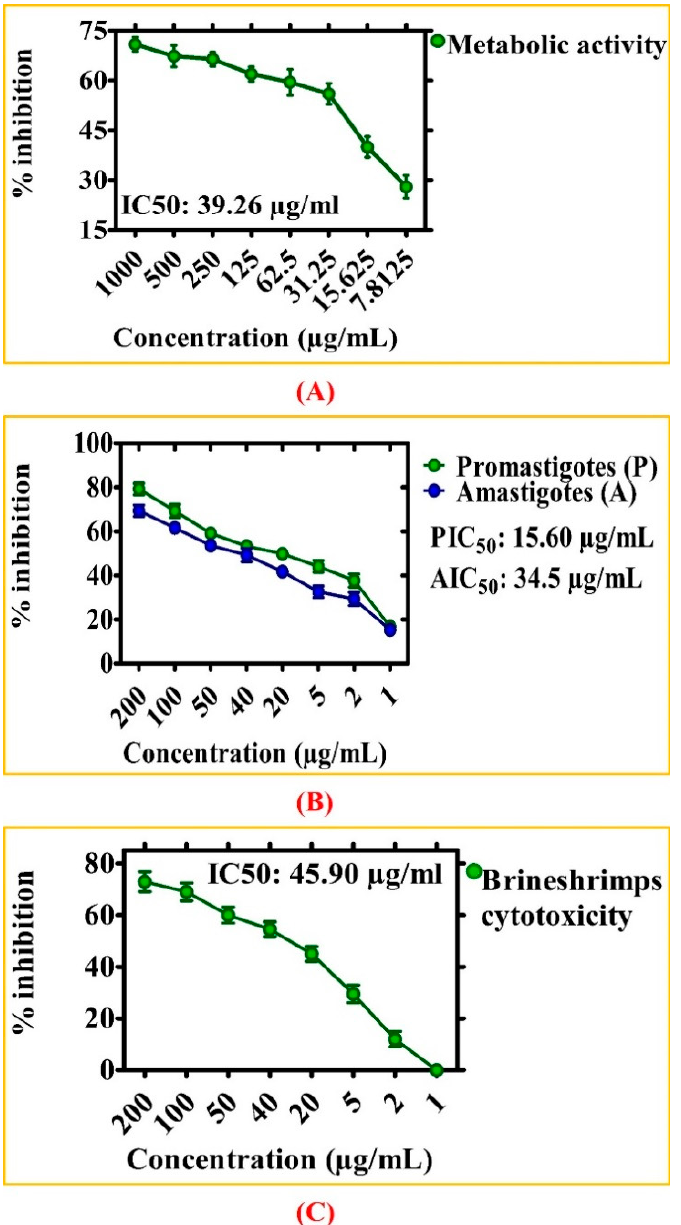
Figure 6. Cytotoxicity assays. The data in all figures represents the mean of three replicates ( A ) Cytotoxicity activities of Geranium wallichianum mediated ZnONPs against HepG2 cell line ( B ) Antileishmanial activities of ZnONPs ( C ) Cytotoxicity against brine